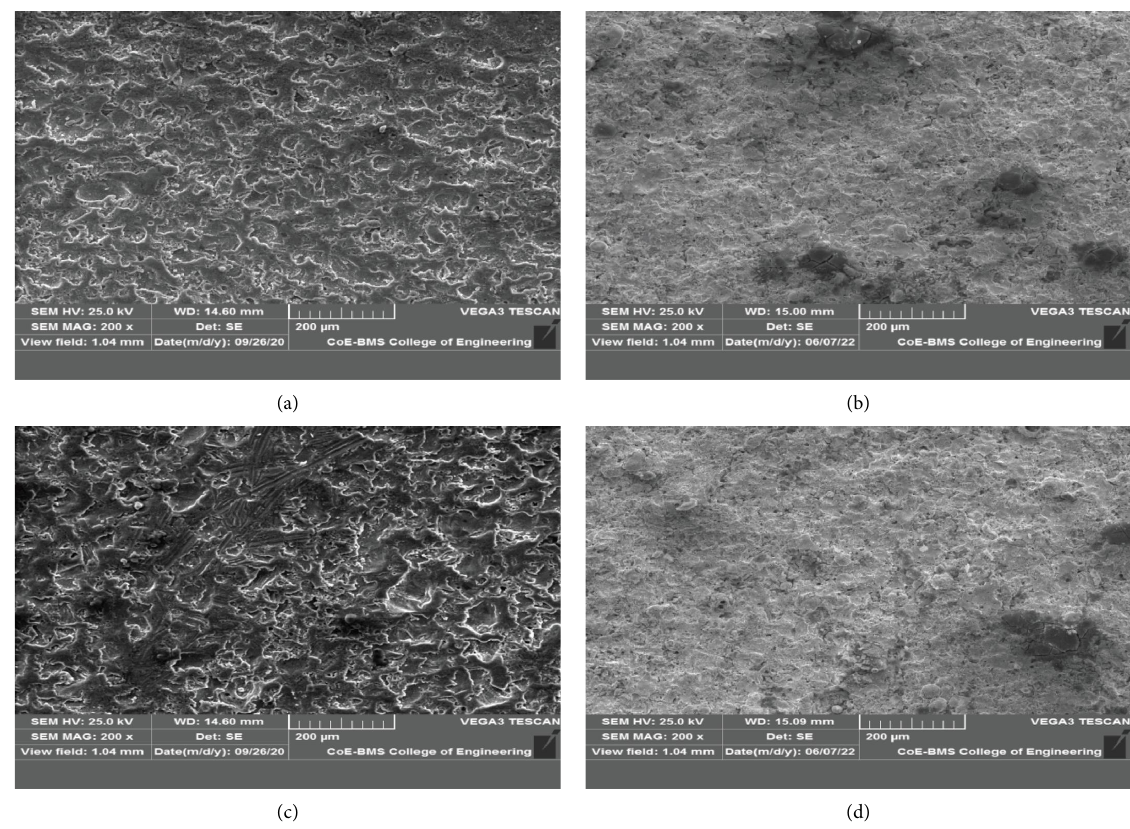
Figure 11: SEM of slurry eroded surfaces under diferent slurry concentrations: (a) Al6061 alloy (50g/litre), (b) coatings